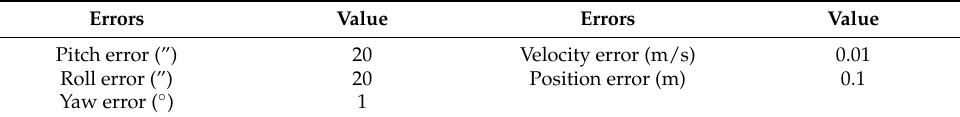
Figure 8. The covariance of installation errors is obtained by simulation.